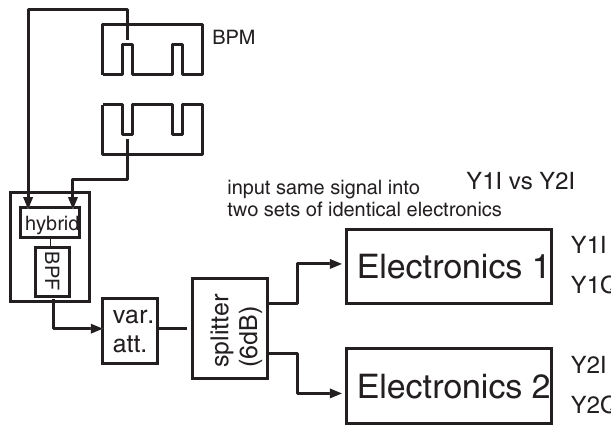
FIG. 12. Setup for testing intrinsic resolution of the elec- tronics. Identical signals divided from one BPM were processed by two sets of